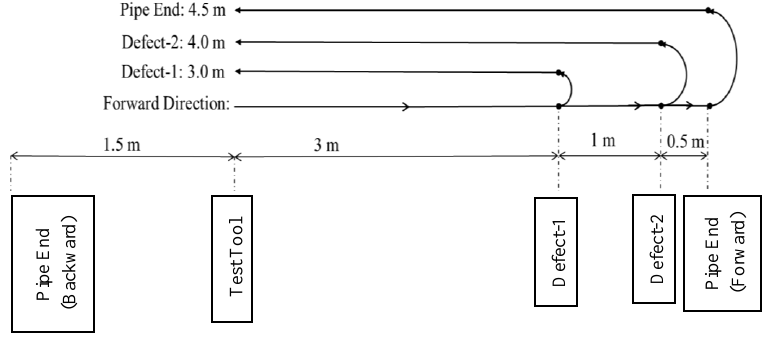
Figure 4. Signal reception routes.